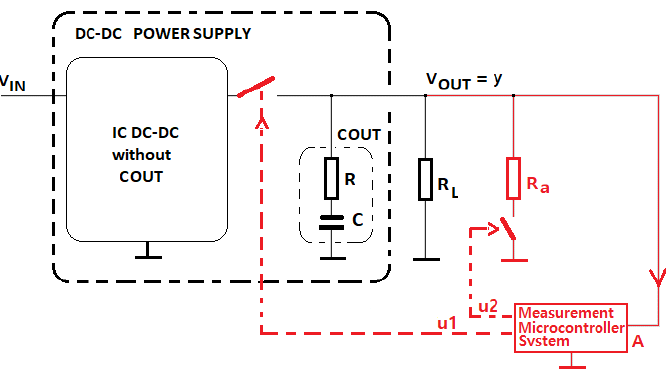
Figure 12. Diagram for determining the transient equivalent values of the COUT capacitor parameters.